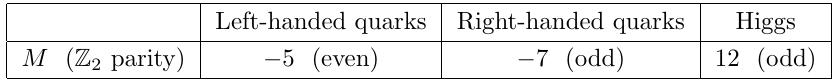
Table 2 . Magnetic (cid:13)uxes for left- and right-handed quarks and Higgs sectors. (cid:13)ux M = 12 appears in the zero-mode equation for the up and down Higgs (cid:12)elds. Then, it turns out that quarks have three degenerate zero-modes, whereas there exist (cid:12)ve degenerate zero-modes for the up and down Higgs sectors. Table 2 shows these